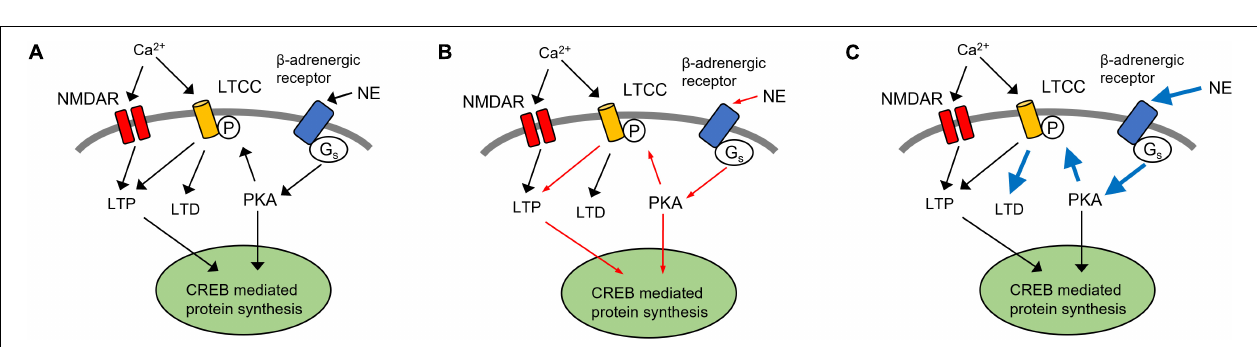
FIGURE 3 | A hypothetical model of LTCCs in NE dysregulation in Alzheimer’s disease. (A) LTCC contribute to both LTP and LTD in olfactory learning. In aged rats, LTD in the piriform cortex (PC) is LTCC-dependent (Rajani et al., 2021). Thus, inhibition of LTCCs in the aging piriform cortex blocks LTD and could enhance learning (Maziar et al., 2022). (B) Following the degeneration of noradrenergic inputs from the LC, a decrease in NE signaling could result in LTCC hypofunction, resulting in the reduction of LTCC-dependent LTP (red arrows). (C) Alternatively, a compensatory increase in extracellular NE and adrenergic receptor expression may lead to enhancement of LTCC-mediated LTD (blue arrows). LTP, long term potentiation; LTD, long term depression; PC, piriform cortex; NE, norepinephrine; LC, locus coeruleus; LTCC, L-type calcium channel; NMDAR, N -methyl- D -aspartate